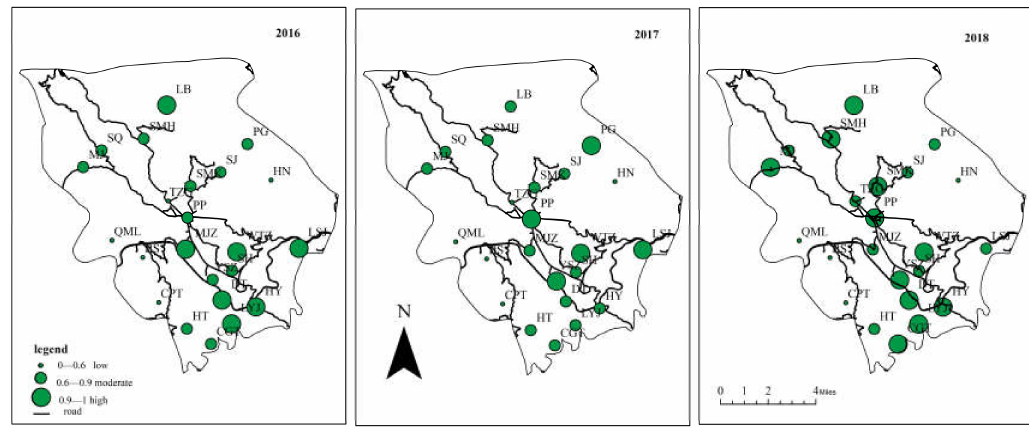
Figure 2. Spatial pattern of the agricultural eco-e ffi